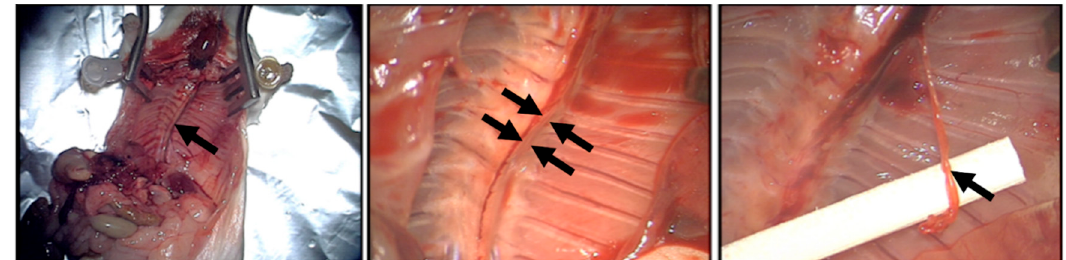
Figure 1. Thoracic Duct Ring Assay. Surgical removal of the thoracic duct, the main lymphatic vessel, under microscopic magnification. The aorta has already been excised and prepared for use in the aortic ring assay. Black arrow(s) show(s) thoracic